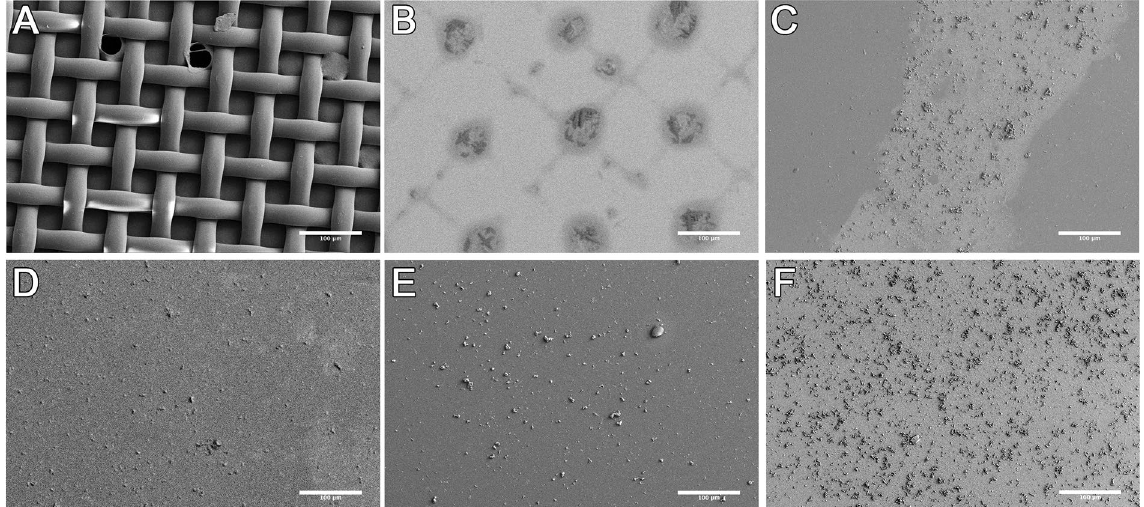
Figure 4. FE-SEM micrographs of mineralization on glass slides patterned with PEGylated proteins. ( A ) A nylon mesh photomask was used to pattern ( B ) PEGylated Nacre WSM, ( C ) BMP2, ( D ) DMP-1, ( E ) BSP, and ( F ) n16N. Scale bars are 100 µm.